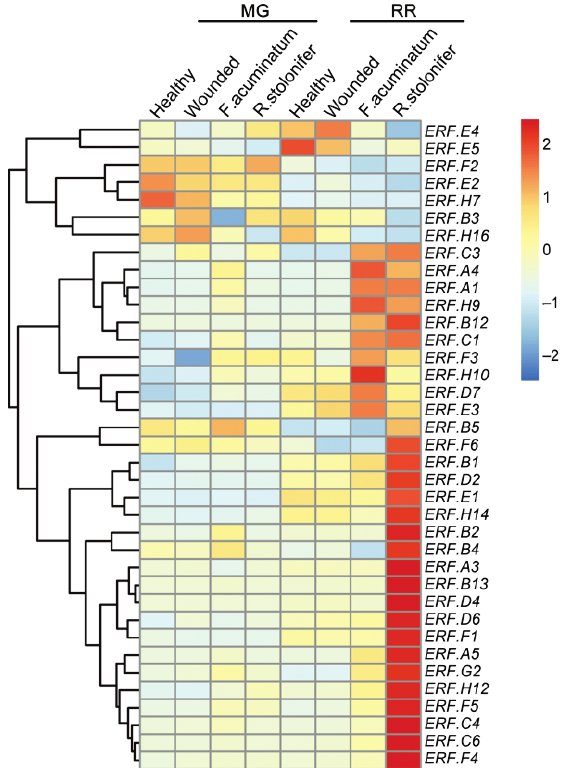
Figure 4. Gene expression pattern of ERFs in tomato wildtype ( Ailsa Craig , AC) fruit infected with F. acuminatum and R. stolonifer. Wildtype AC tomato fruits were picked at mature green (MG) and red ripe (RR) stages, which included control (wounded but did not infected), wounded plus in- fected with F. acuminatum and R. stolonifer , respectively. Raw transcriptome data (accession num- ber: GSE148217) were downloaded from the NCBI database and transformed to FPKM using hisat2 tools. The FPKM values were normalized by row and displayed with color ranging from blue (low) to red (high). Genes with FPKM value below 10 in all the tissues were considered as low-level transcripts and were not displayed in the